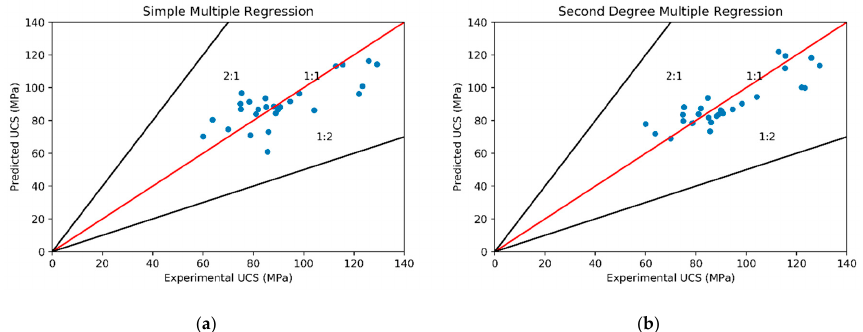
Figure 5. Predicted UCS vs. experimentally determined UCS. ( a ) (Equation (22)) and second degree multiple regression ( b ) (Equation (23)).